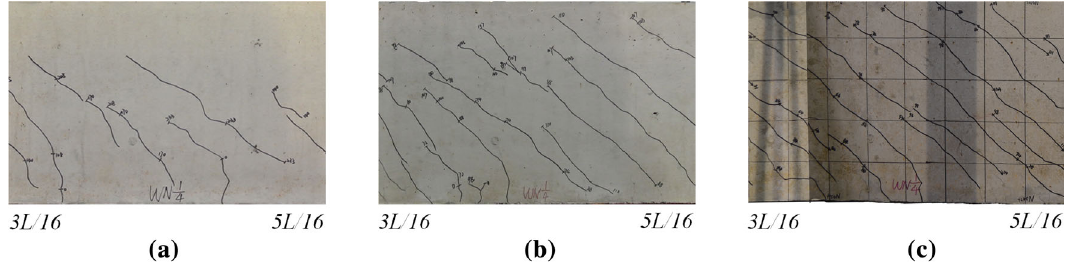
Fig. 8 Photos of external surface of loaded web at L /4-span at ultimate state: a MEM-1:5, b MEM-1:1, and c MEM-1:0. International Journal of Concrete Structures and